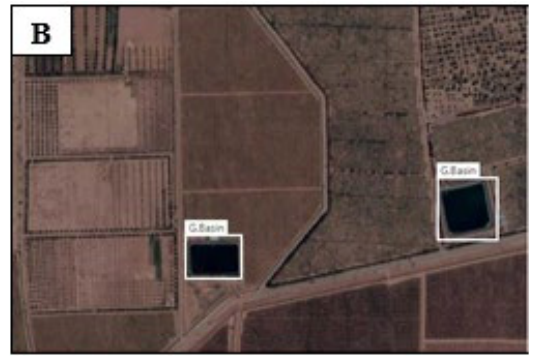
Figure 3. A,B: Image labelling with bounding boxes using label- studio software.